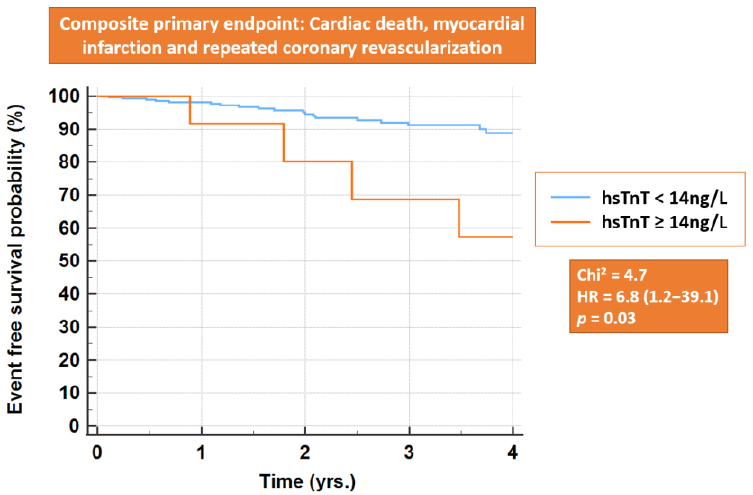
Figure 3. Kaplan-Maier analysis. Higher rates of cardiac events are present during follow-up in patients with elevated (n elevated = 14) versus normal baseline hsTnT (n normal = 332) ( p = 0.03 by log-rank test).